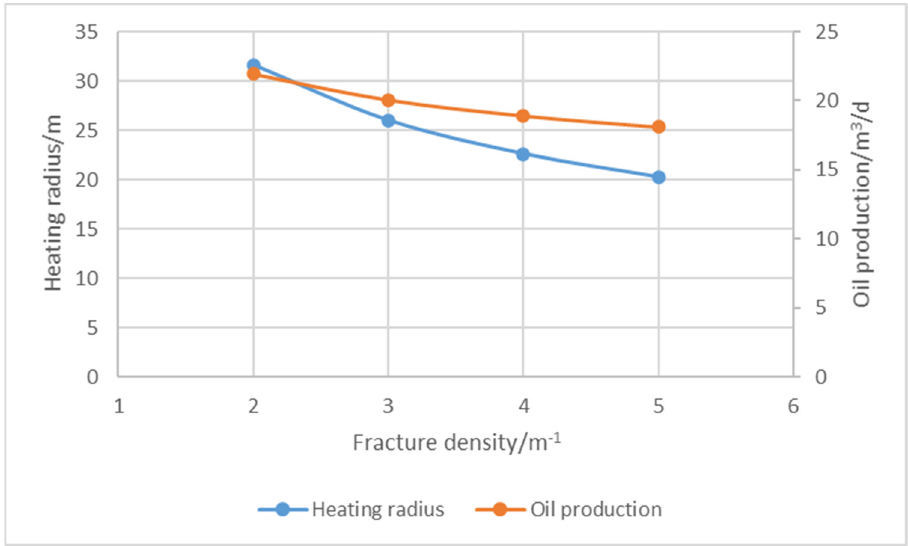
Figure 4. Fracture density vs. heating radius.